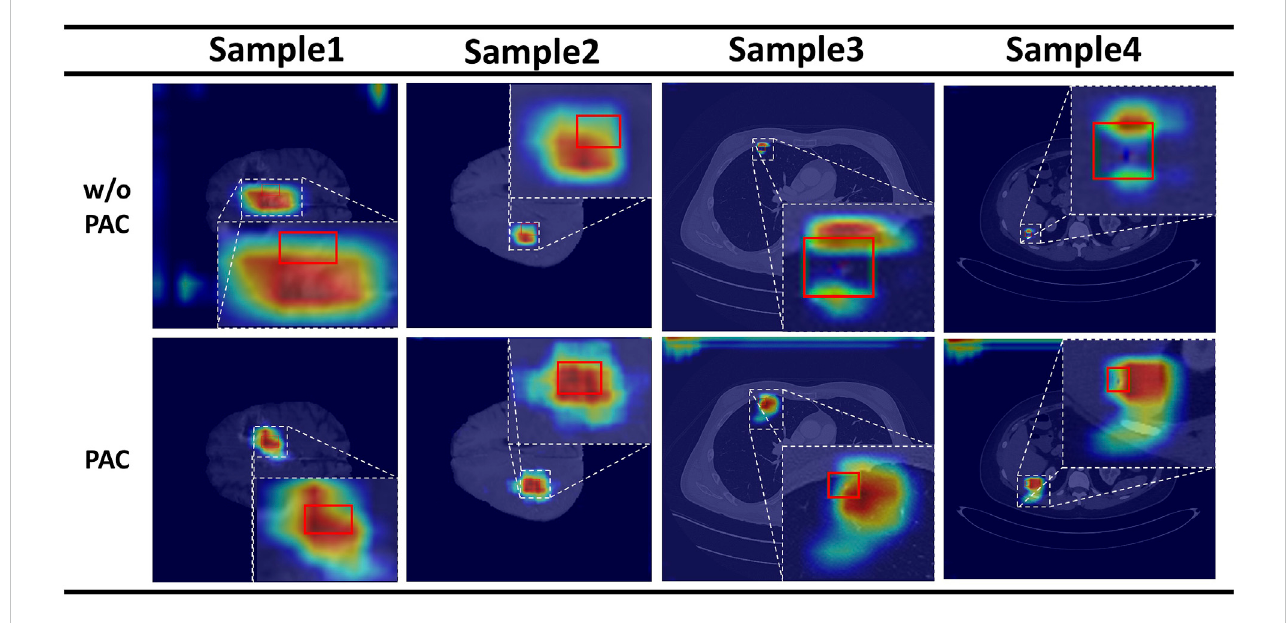
FIGURE 4 Results of the attention heat map. Above is the result without PAC, and below is the result with